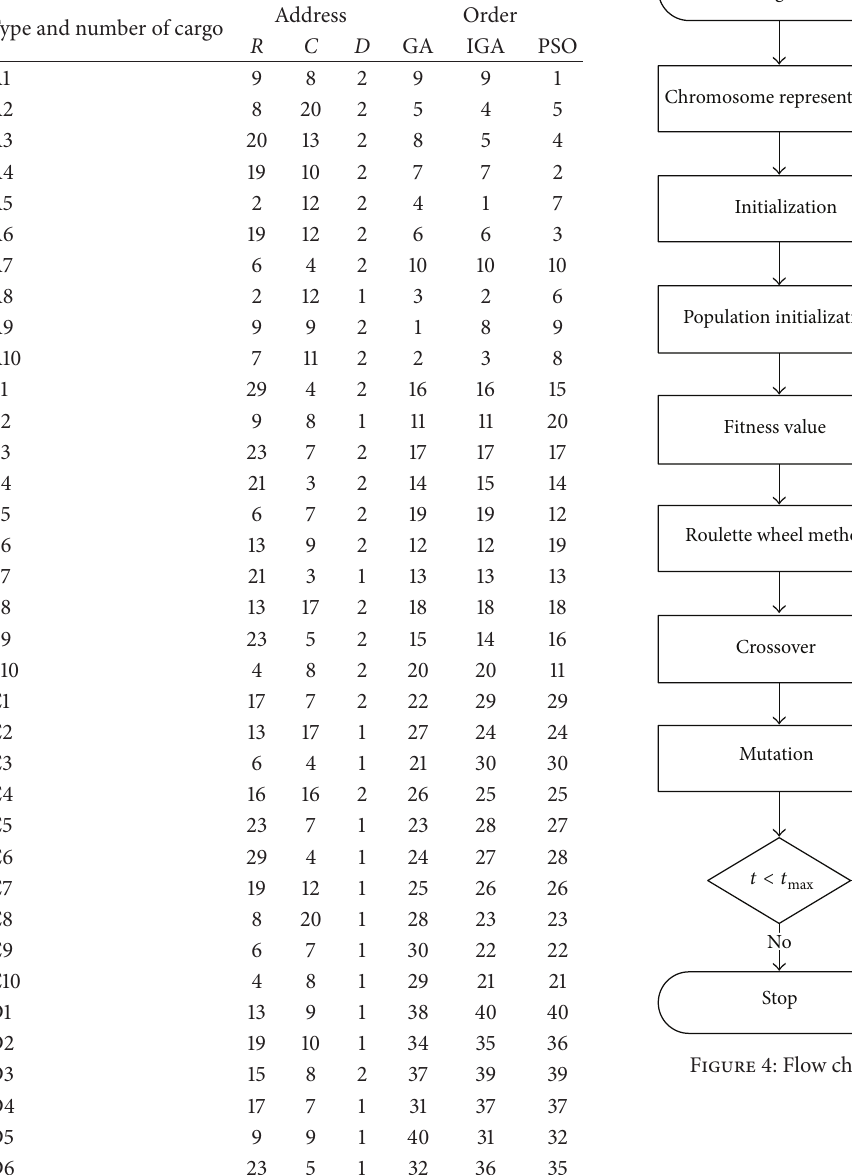
Step 1 (chromosome representation). Produce various com- binations of different retrieval orders and give the number to represent